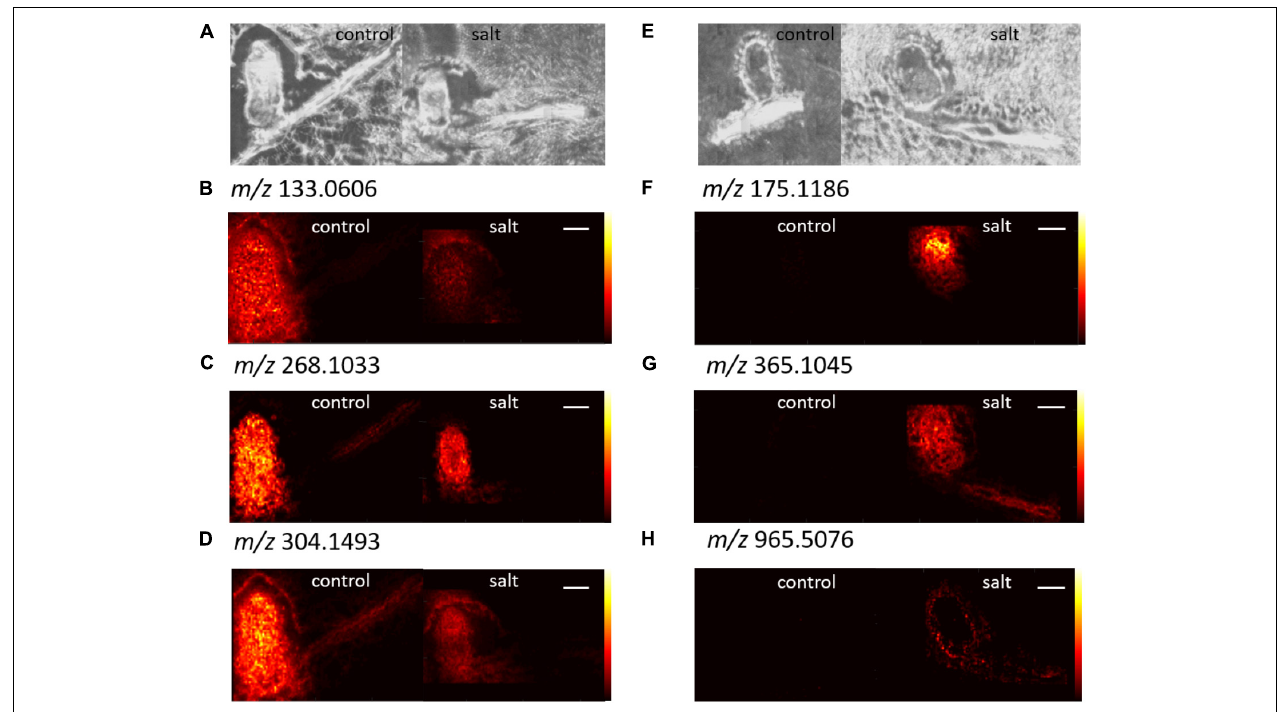
FIGURE 7 | AP-MALDI MSI images for the identifications in Table 1 (B–D) and Table 2 (F–H) . (A) Shows the optical image for the control identification (B–D) and (E) shows the optical images for salt identifications (F–H) . Images in (B–D,F–G) were with CHCA as the matrix and (H) was with DHB as the matrix. The white scale bar corresponds to 1